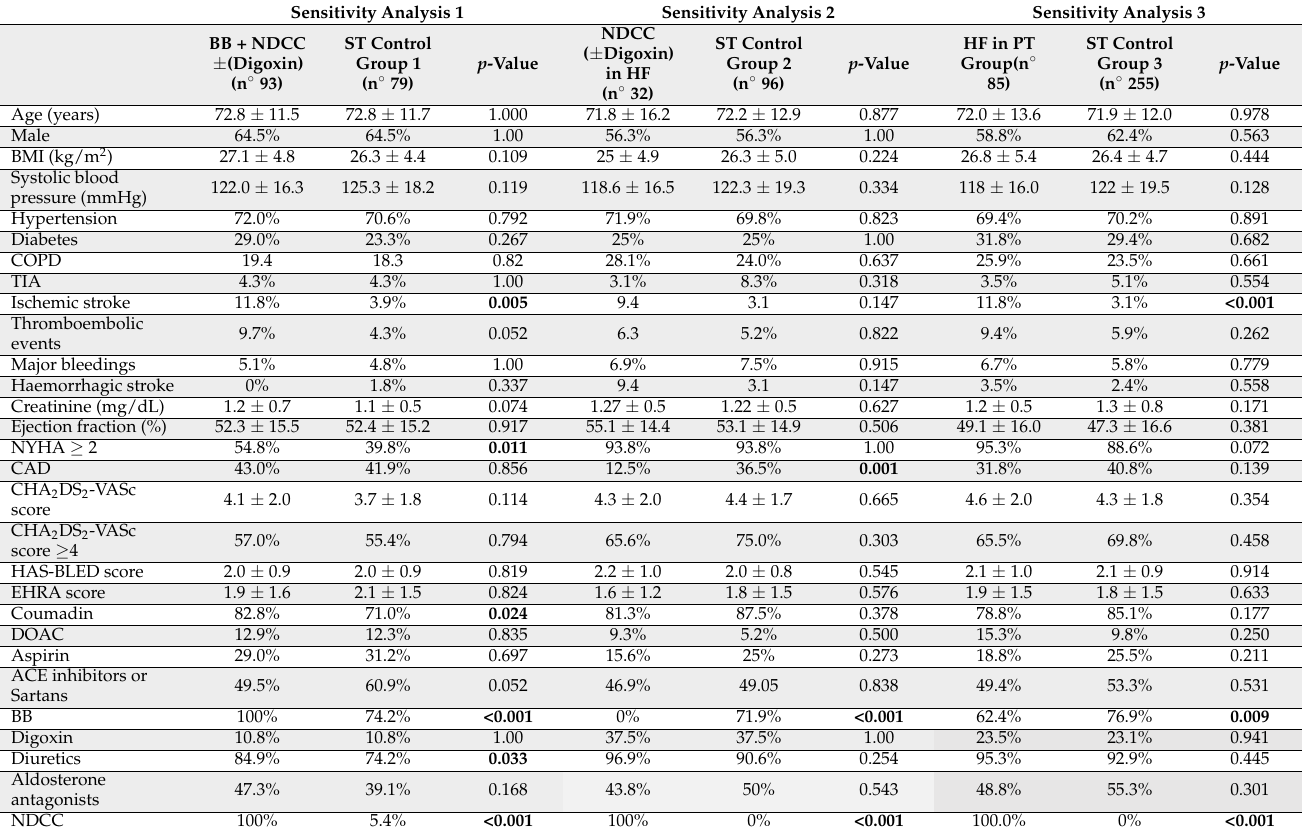
Table 3. Baseline characteristics of the patients in the PT subgroups and respective ST control